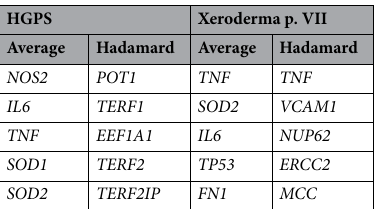
Table 7. Top 5 predictions of new gene-disease associations for HGPS and Xeroderma pigmentosum VII by MultiVERSE combined with Average and Hadamard operators.